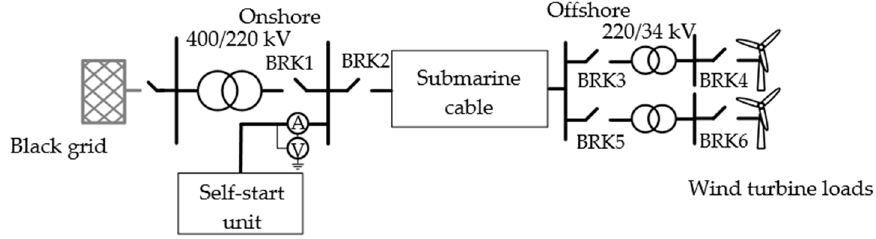
Figure 3. Simplified benchmark with self-start unit for preliminary system studies.